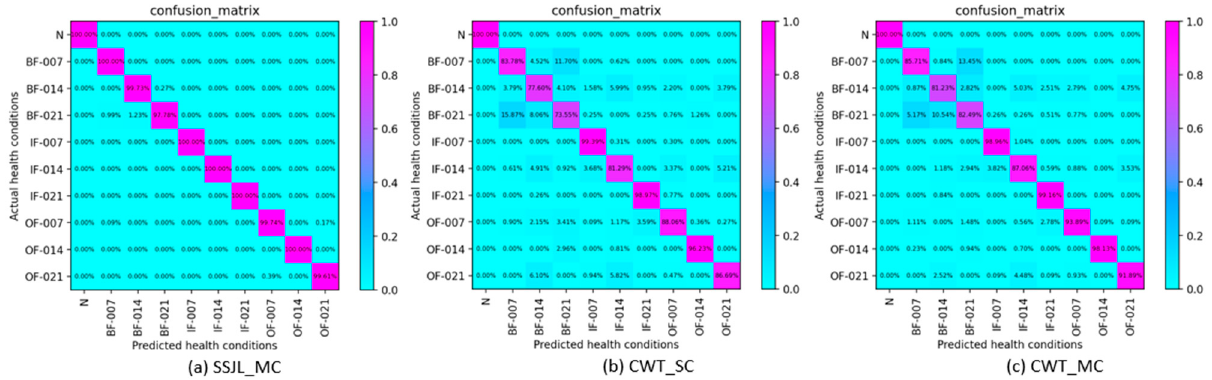
Figure 7. Confusion matrix of different methods: ( a ) SSJL_MC, ( b ) CWT_SC, and ( c ) CWT_MC.